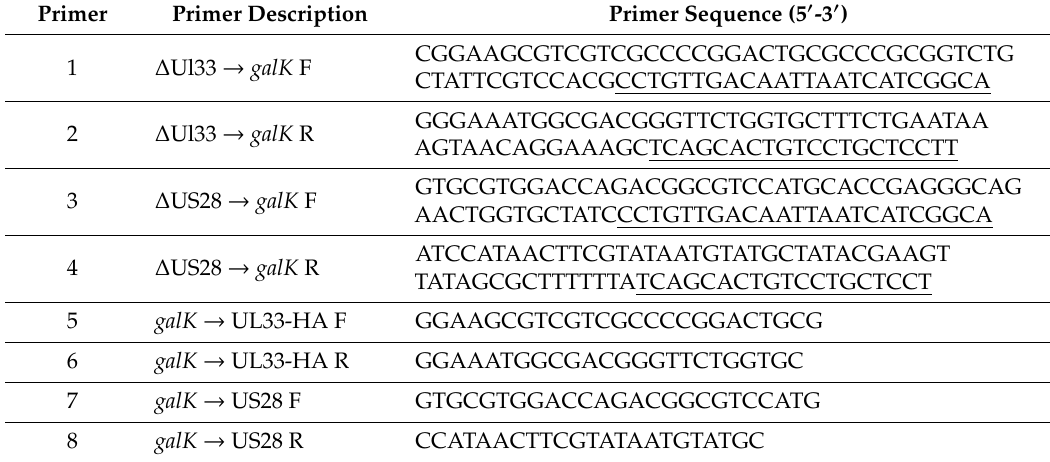
Table 1. Primers used for bacterial artificial chromosomes (BAC) recombineering and sequencing: Primers 1–4 were used to introduce galK (homology arm, sequence recognizing galK ), and primers 5–8 were used to reintroduce UL33-HA or US28. The oligonucleotides were purchased from Eurofins Genomics, Ebersberg,